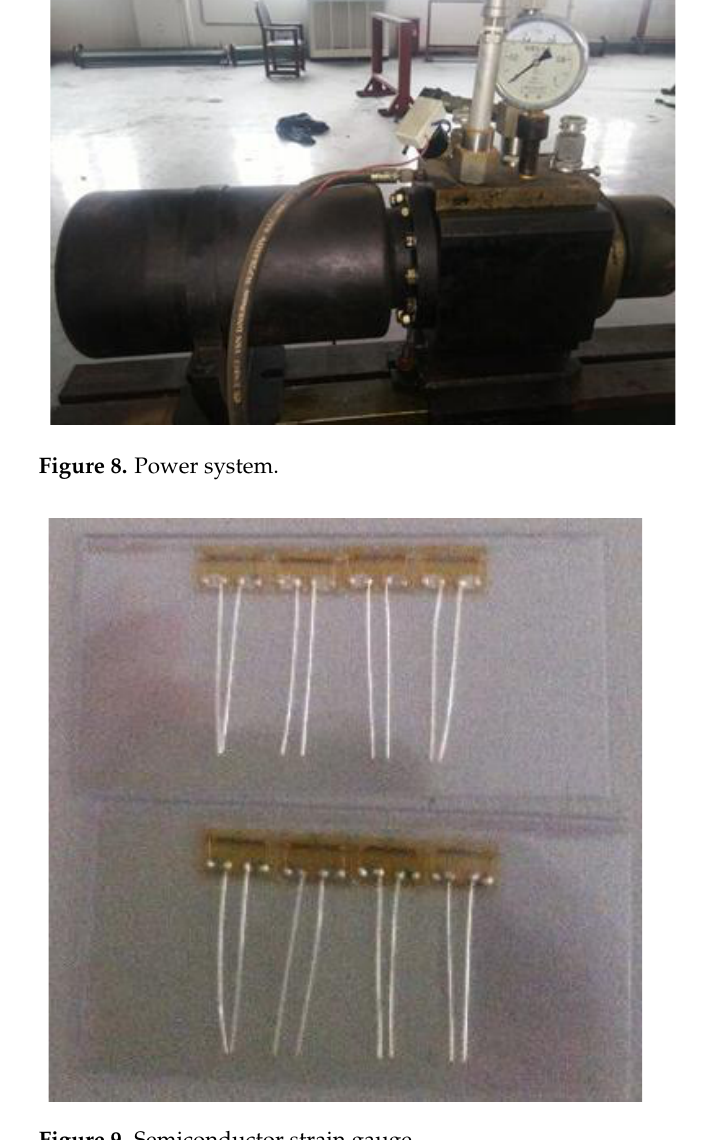
Figure 10. DHHP-20 ultra-dynamic strain gauge.